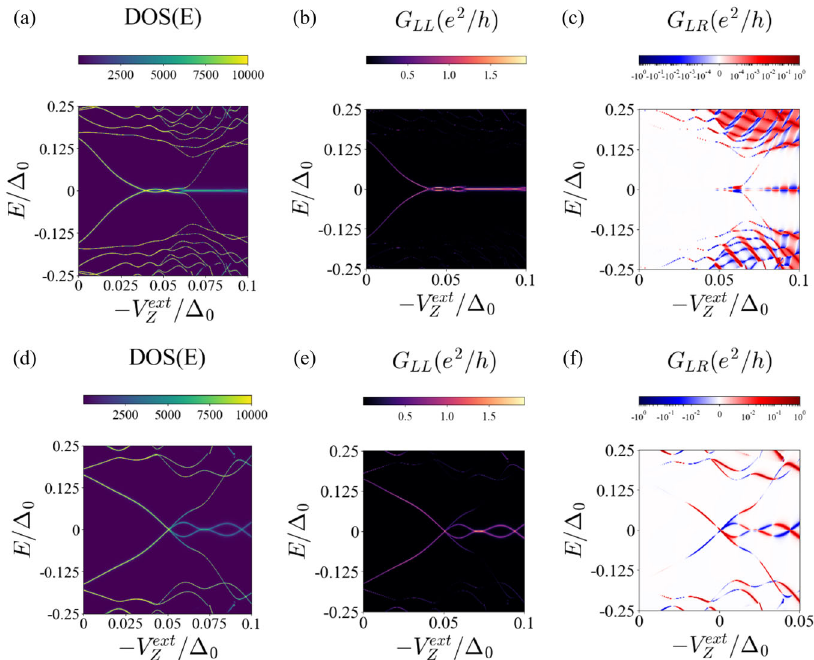
Fig. 5 Conductance spectra for the disordered nanowire. a Low Energy density of states (DOS) b local and c non-local conductance spectra for a nanowire of length 4.5 μ m, with a potential pro fi le as shown in Fig. 1d. d Low energy DOS, e the local and f the non-local conductance conductance spectra for